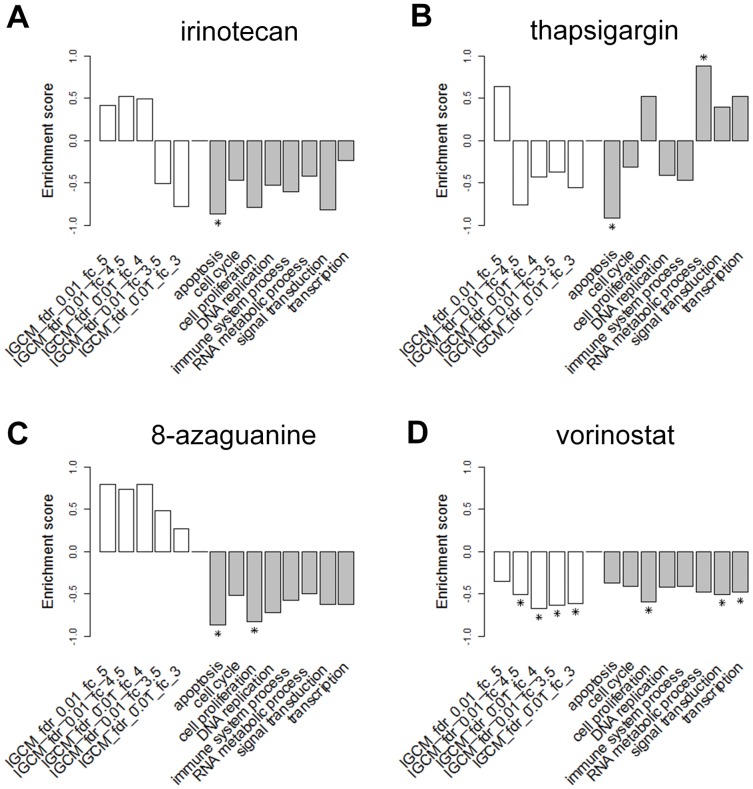
Enrichment scores of known anti-cancer drugs.(A) irinotecan, (B) thapsigargin, (C) 8-azaguanine, and (D) vorinostat. CMap querying gene sets are shown on the horizontal axis. The first five entries from left are whole DEG sets selected by SAM using FDR = 0.01 and FC ranging from 3.0 to 5.0. The rest are the eight functional module selected by GSToP with FC = 2.0. Star indicates permutation p-value<0.005.